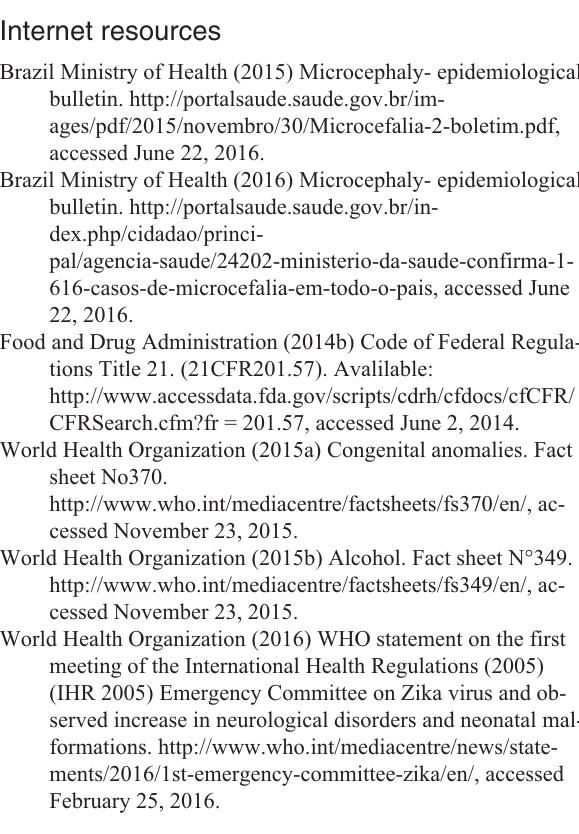
Table S1 - Main teratogen categories and respective em- bryo-fetal effects during pregnancy. Table S2 - Cases involving congenital anomalies from 2008 to 2013. Table S3 - Fetal deaths involving congenital anomalies from 2008 to 2013. Table S4 - Infant hospitalizations involving congenital anomalies from 2008 to 2013. Table S5 - Number of deaths of infant hospitalized involv- ing congenital anomalies from 2008 to 2013. Table S6 - Average cost in US dollars of hospitalizations involving congenital anomalies from 2008 to